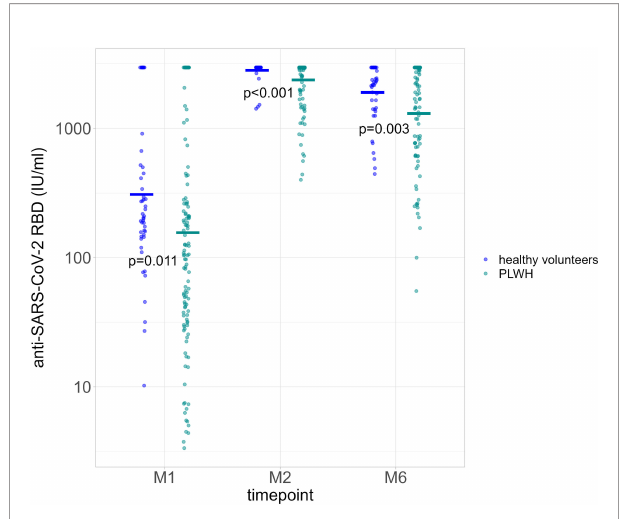
FIGURE 1 | Quanti fi cation of anti-RBD Ig (GMT) in healthy volunteers (blue dots) and people living with HIV (PLWH, green dots) at each time point. P value signi fi cant if <0.05. RBD, receptor binding domain; GMT, geometric mean titers; PLWH, people living with HIV; M1, 30 days after the fi rst vaccine dose; M2, 60 days after the fi rst vaccine dose; M6, 6 months after the fi rst vaccine dose.